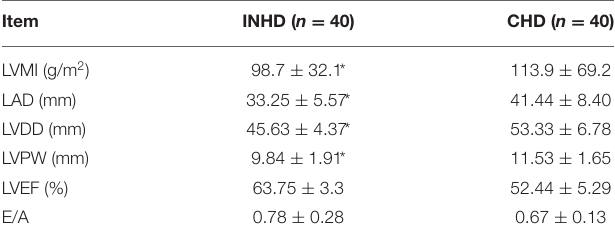
LVMI, left ventricular mass index; LAD, left atrial dimension; LVDD, left ventricular end diastolic dimension; LVPW, left ventricular posterior wall; LVEF, left ventricular ejection fraction. * p <